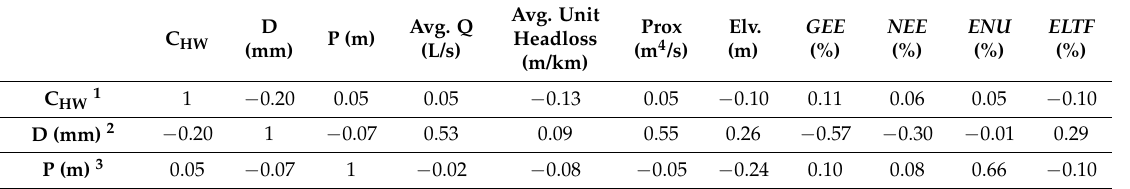
Table 3. Correlation matrix of energy metrics and pipe hydraulic factors